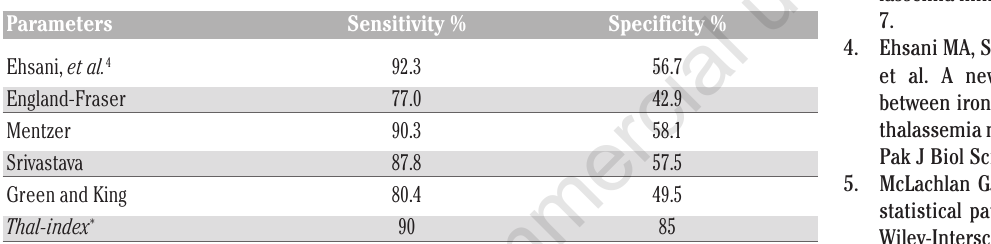
Table 2. Comparison of different indices used in the